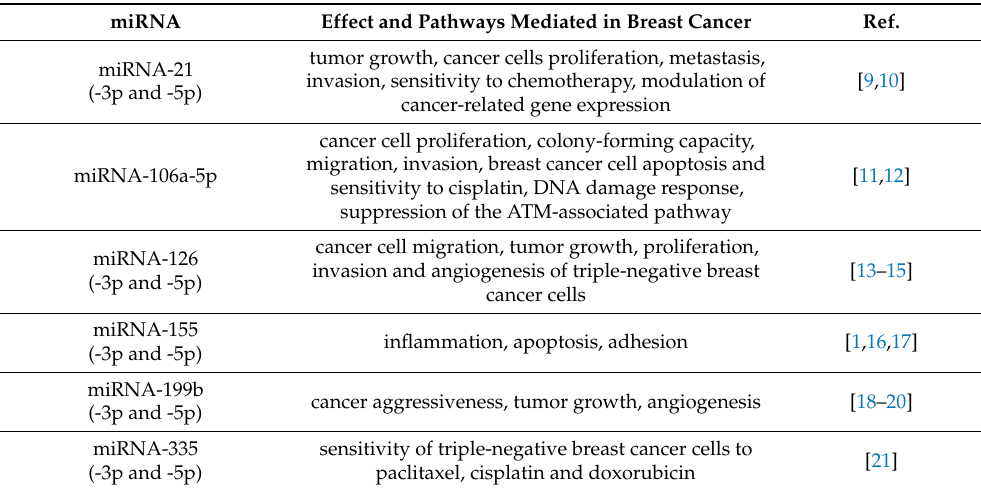
Table 1. Contribution of selected miRNAs to breast cancer metabolism. miRNA Effect and Pathways Mediated in Breast Cancer Ref. tumor growth, cancer cells proliferation, metastasis, miRNA-21 invasion, sensitivity to chemotherapy, modulation of (-3p and -5p) cancer-related gene expression